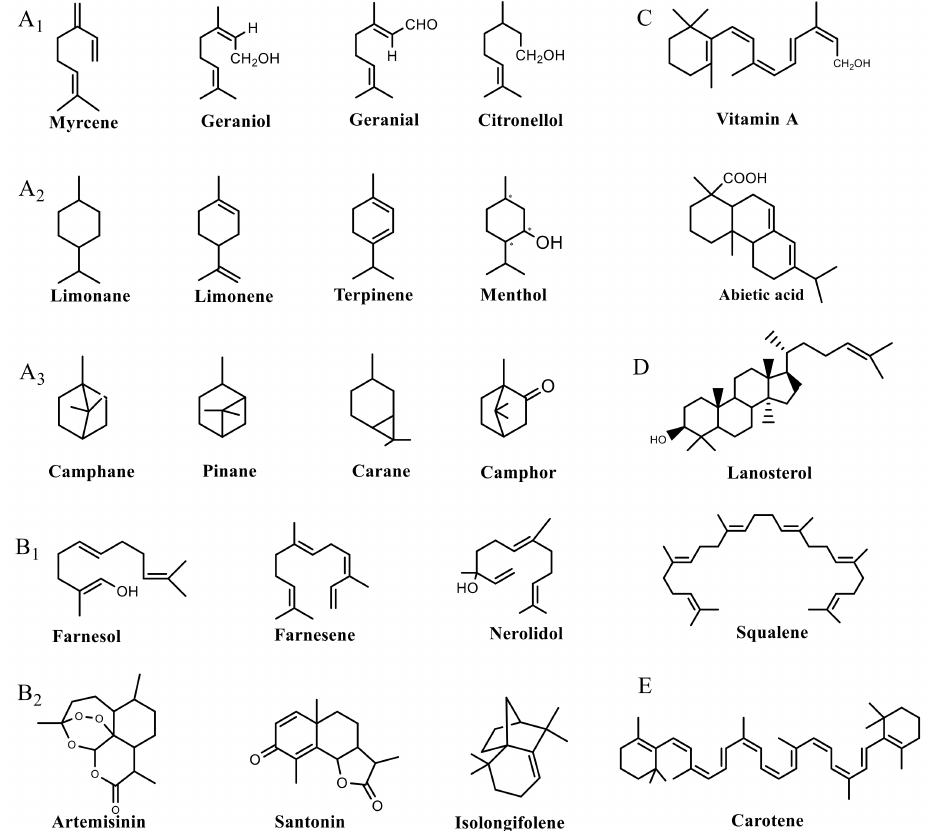
Figure 2. Classification of terpenoidsin plant. ( A ): monoterpenes, A 1 : Open-chain, A 2 : Single ring, A 3 : Bicyclic; ( B ): sesquiterpenes, B 1 : Open-chain, B 2 : Cyclic; ( C ): Diterpenes; ( D ): Triterpenes; ( E ):